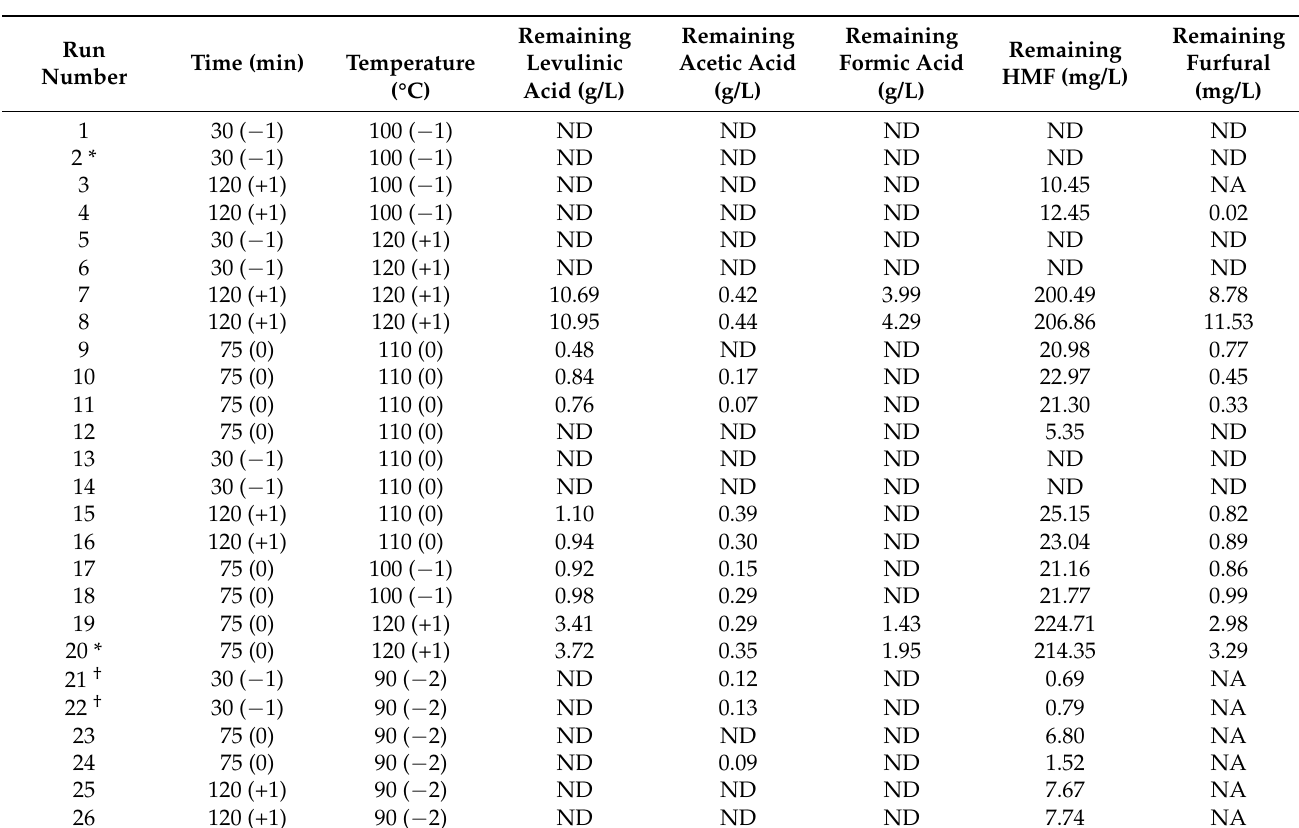
Table 5. Inhibitor remaining after cell culture for the different test conditions. Potato/acid ratio: 1/2. † runs for which an artifact was observed (tube not properly sealed during acid hydrolysis). * runs for which pH was over-adjusted inducing an excessive dilution. NA—Not Available, ND—Not Detected.